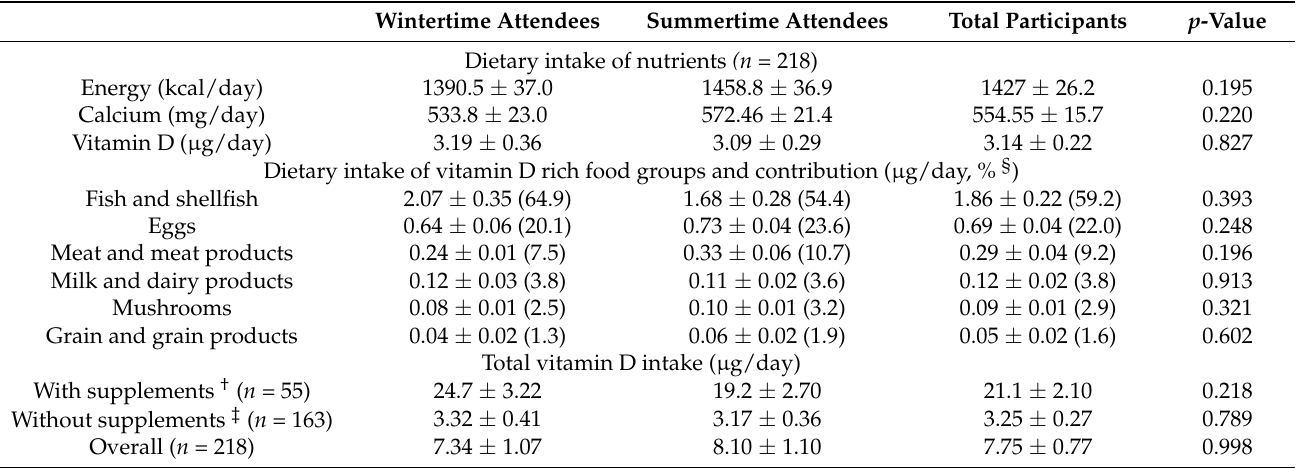
Table 2. Energy, calcium, and vitamin D intake in wintertime and summertime.